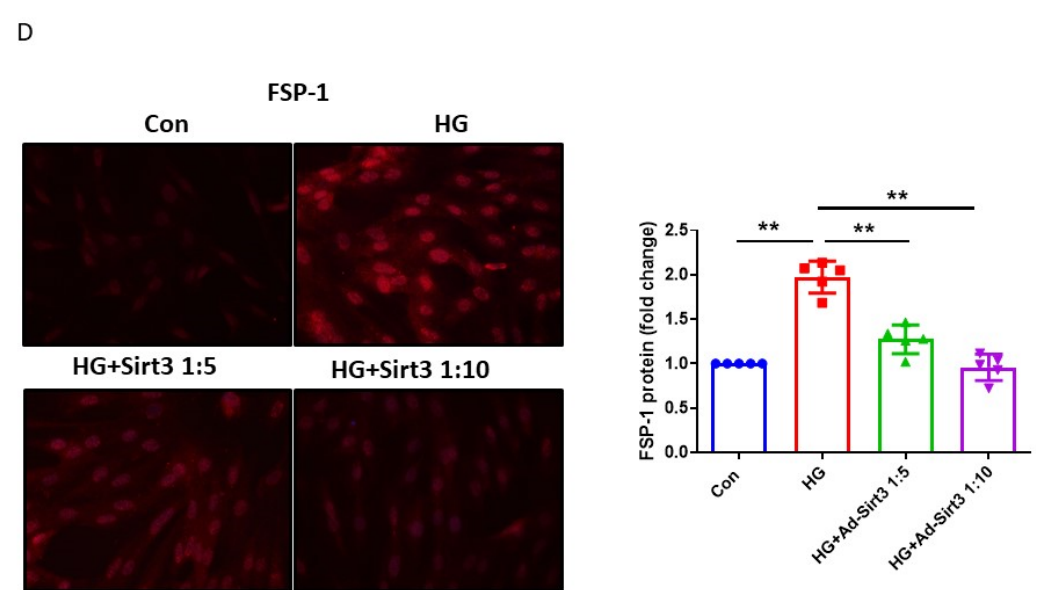
Figure 5. SIRT3 blunts HG-induced p53 expression and modulates hypoxic signaling in H9c2 cells. ( A ) Exposure of H9c2 cells to different concentrations of glucose (15, 30, 45 mM) for 72 h resulted in a dose-dependent reduction in SIRT3 expression as compared to normal glucose (5.5 mM). Densit- ometries showed a significant reduction of SIRT3 expression at 30 mM and 45 mM concentrations. Ad-SIRT3 treatment significantly attenuated the HG (30 mM)-induced p53 expression. All data represent mean ± SD (n = 3 per group, * p < 0.05 and ** p < 0.01). ( B ) Ad-SIRT3 treatment blunted HG (30 mM)-induced upregulation of PHD1 and PHD2. Data represent mean ± SD (n = 3 per group, * p < 0.05 and ** p < 0.01). ( C ) Ad-SIRT3 treatment resulted in a dose-dependent upregulation of HIF-1 α expression in H9c2 cells under HG (30 mM) conditions. Data represent mean ± SD (n = 3 per group, ** p < 0.01). ( D ) Levels of FSP-1 protein immunostaining revealing that Ad-SIRT3 treatment significantly reduced FSP-1 levels in cultured H9c2 cells under HG (30 mM) conditions (20X Magnifi- cation). All data represent mean ± SD (n = 3 per group, ** p < 0.01). Circle, square and triangle were denoted the different experiment groups as indicated in the